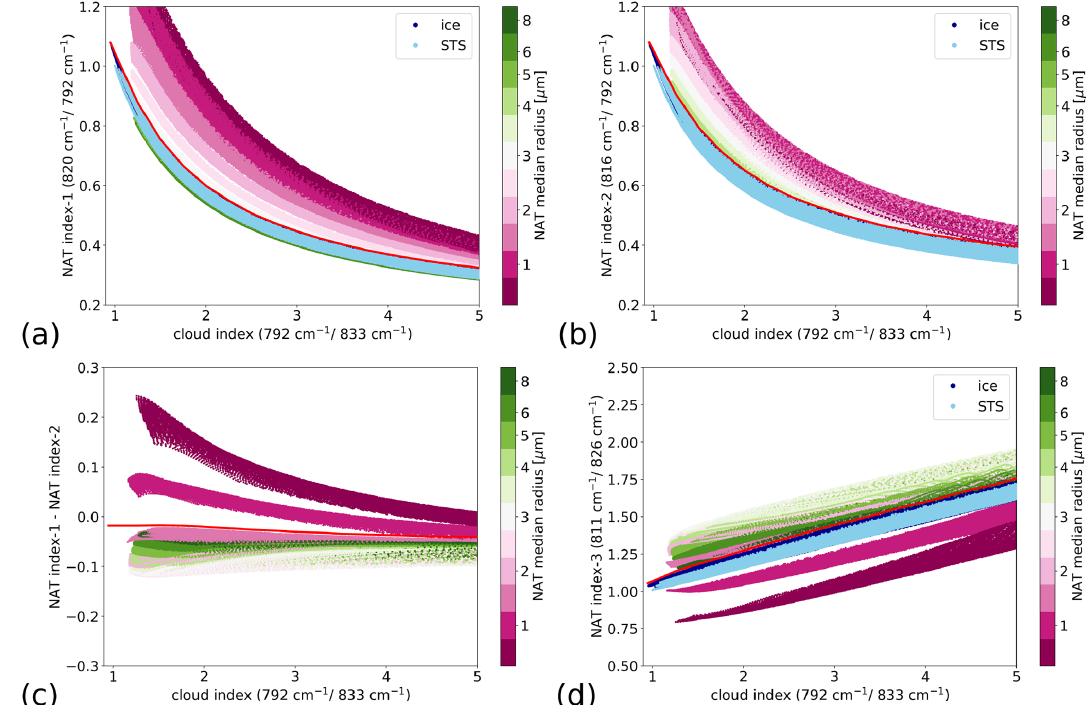
Figure 3. Correlations between different NAT indices and the cloud index for the simulated PSC scenarios: (a) NAT index-1 (819– 821cm − 1 )/(791–793cm − 1 ); (b) NAT index-2 (815–817cm − 1 )/(791–793cm − 1 ); (c) NAT index-1 – NAT index-2; (d) NAT index-3 (810– 812cm − 1 )/(825–827cm − 1 ). The red lines show the separation lines, which mark the upper envelope of the regions of STS and ice defined by the blue coloured areas (in panels a , b , and d ) and the region of medium and large NAT with radii greater than 1.0µm (in panel c ). Simulation results for ice and STS are in shown in dark and light blue respectively.